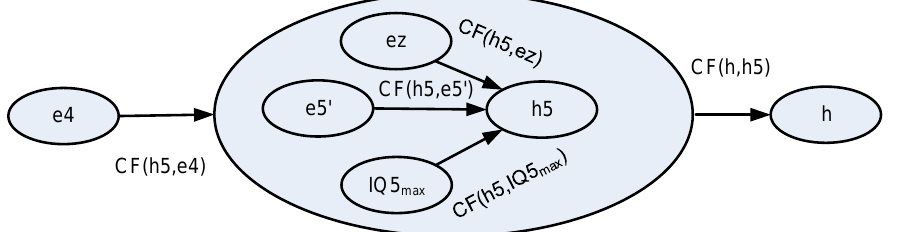
e z Figure 11. IQ model of the fifth information status for the example with double traffic lights and impact of the ez interpretation- interfering element considered (the authors’ own study). As previously, the IQ5 max value was set at 0.9999. The ez value was set at − 0.01, cor- responding to the theorem that one percent of drivers confuse intersection traffic control light colour. Using the method described above in this section, the authors determined the information quality for both solutions: Model with traffic light redundancy from Figure 11: IQ5a = CF(h5, h4a) + CF(h5, h4b) + CF(h5, h4a) · CF(h5, h4b) = = −0.000102 − 0.000102 + (−0.000102) · (−0.000102) = −0.000204